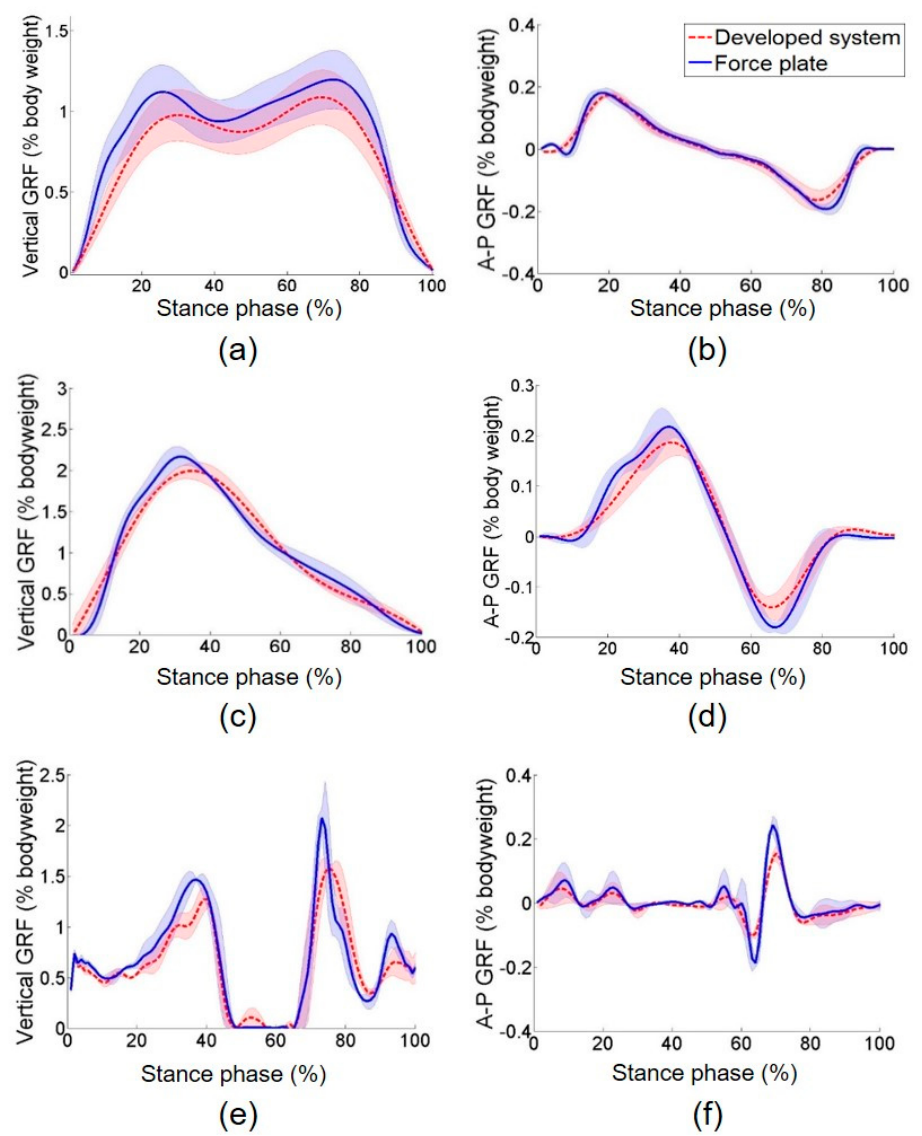
Figure 9. Walking, running, and jumping experimental results. Vertical ground reaction force with the percentage bodyweight of a subject measured wearing the developed GRF measurement system during ( a ) walking, ( c ) running, ( e ) and jumping. Anterior posterior ground reaction force with the percentage bodyweight of a subject measured wearing the developed GRF measurement system during ( b ) walking, ( d ) running, ( f ) and jumping.